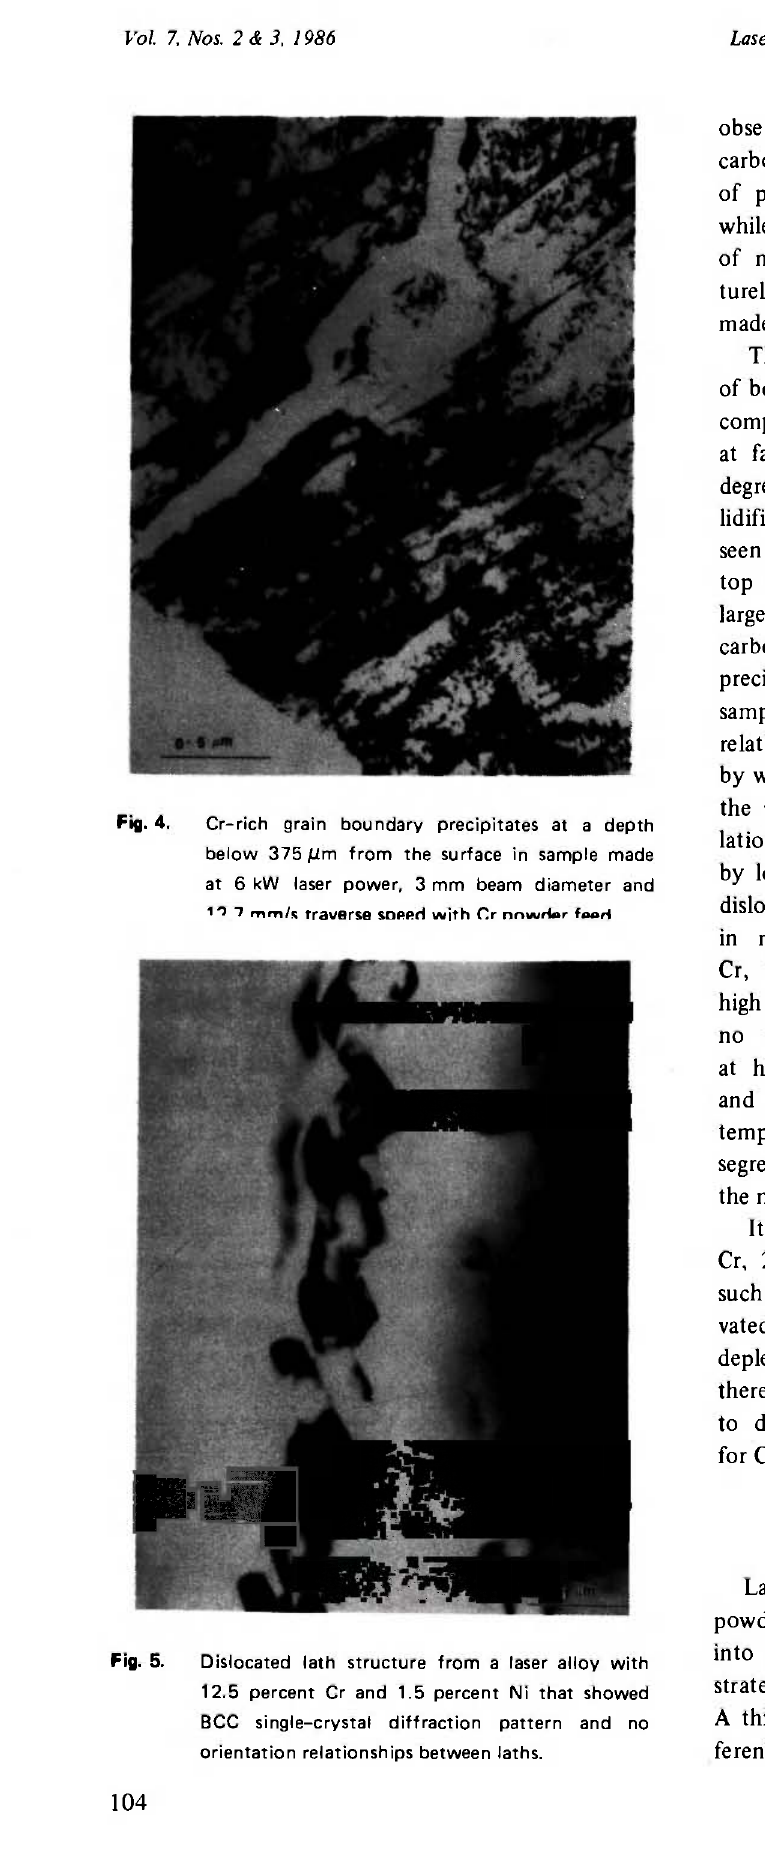
Fig. 5. Dislocated lath structure from a laser alloy with 12.5 percent Cr and 1 .5 percent Ni that showed BCC single-crystal diffraction pattern and no orientation relationships between